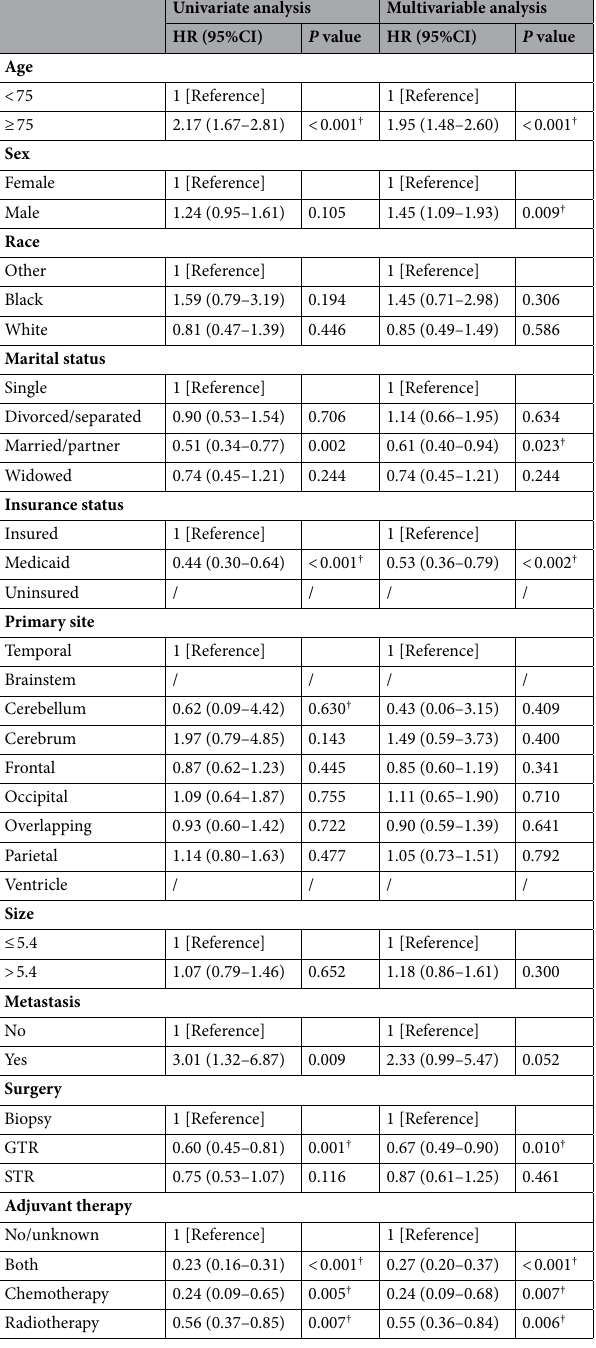
Table 2. Univariate and multivariable cox proportional analyses for non-GBM related death in elderly patients with glioblastoma. GTR gross total resection, STR subtotal resection. † P < 0.05, statistically